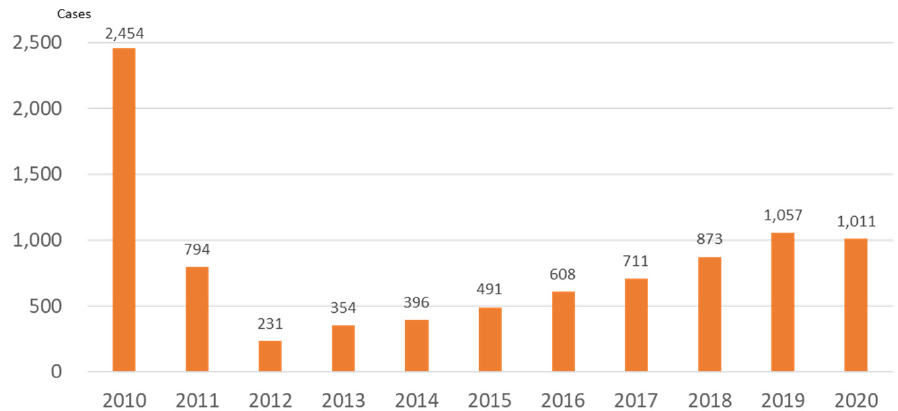
Figure 3. Ambulance transports by the Futaba Fire Department before and after the Fukushima accident (2011).